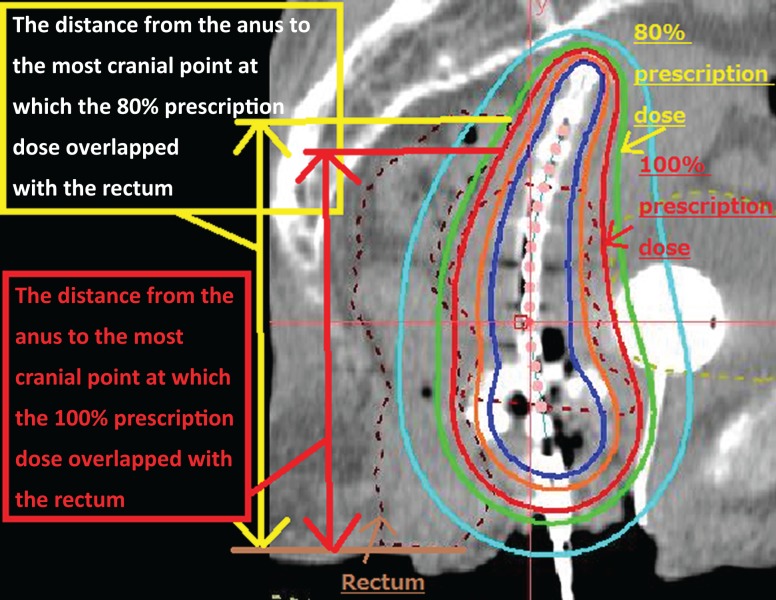
Pre-HGI CT image in sagittal view. The length from the anal verge to the most cranial point at which the 100% and 80% isodose line crossed the rectum on the pre-HGI image were defined as Lcranial100% and Lcranial80%, respectively. The red line indicates the 100% isodose line and the green line the 80% isodose line. The brown dotted line marks the rectum.